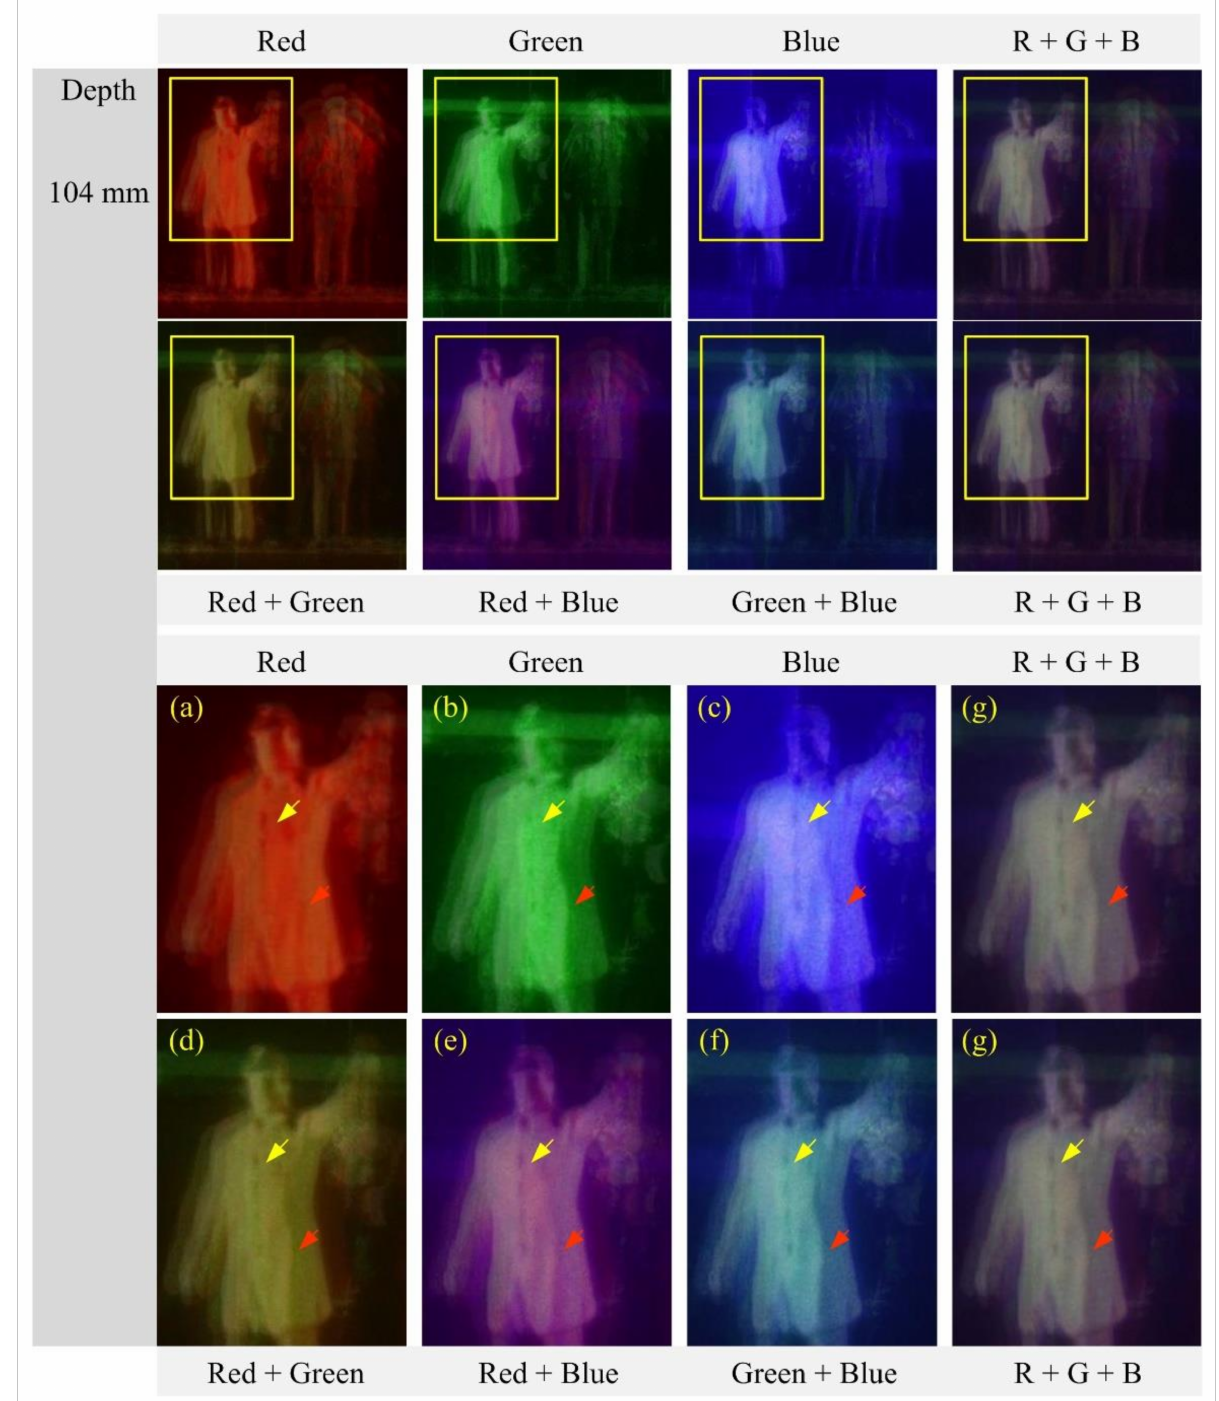
Figure 14. Reconstructed images and their zoomed versions for the human object at the depth z = 104 mm. ( a ) Red ( b ) Green ( c ) Blue ( d ) Red + Green ( e ) Red + Blue ( f ) Green + Blue, and ( g ) Red + Green + Blue